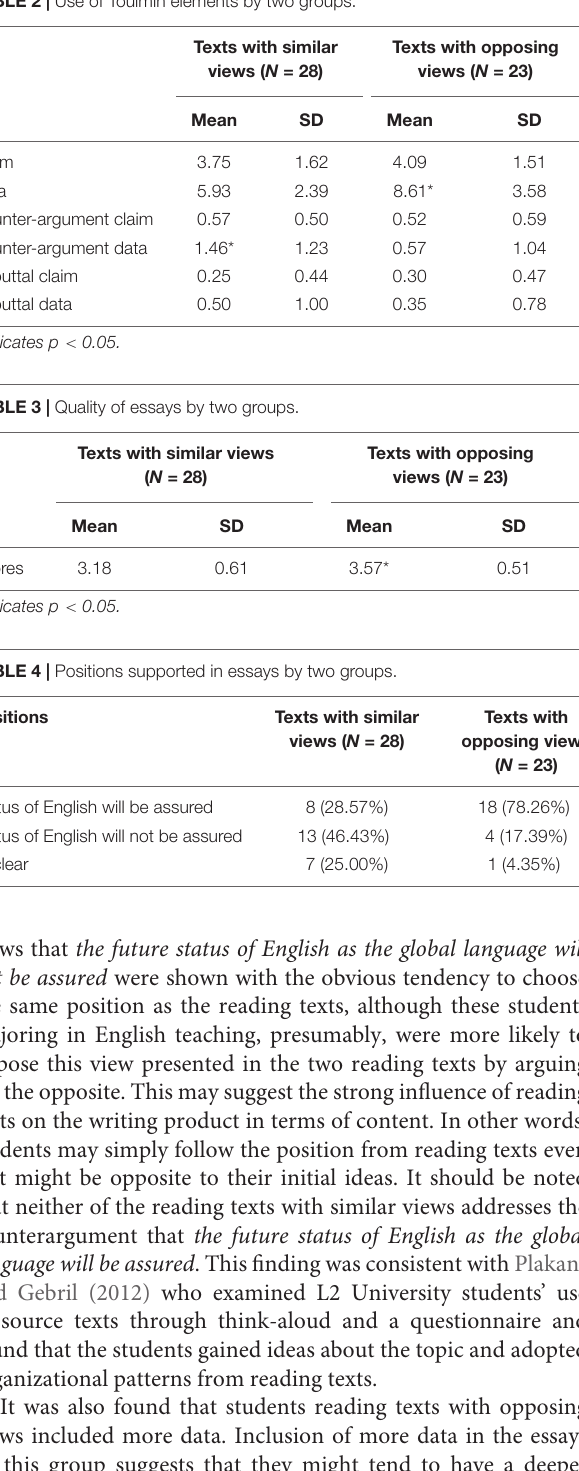
TABLE 2 | Use of Toulmin elements by two groups.